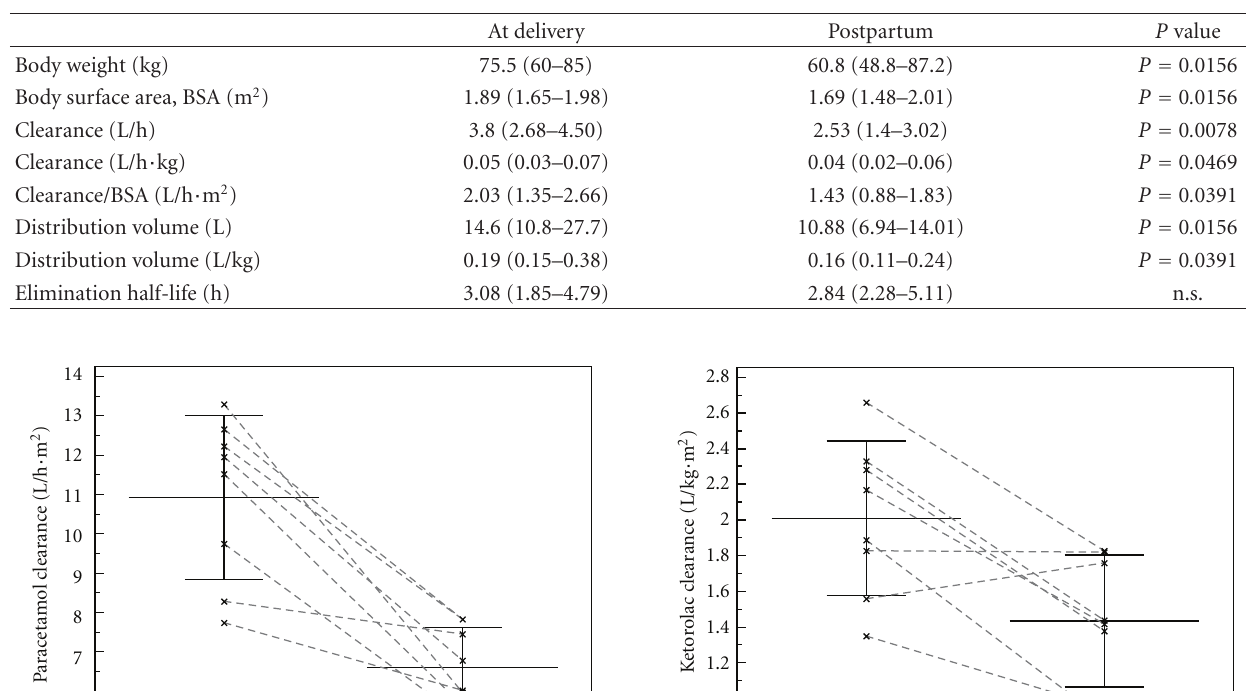
Table 2: Clinical characteristics and pharmacokinetic estimates for intravenous ketorolac (single dose, 30mg) in 8 women as collected at delivery and in postpartum (17–23 weeks after delivery). Data provided by median and range.